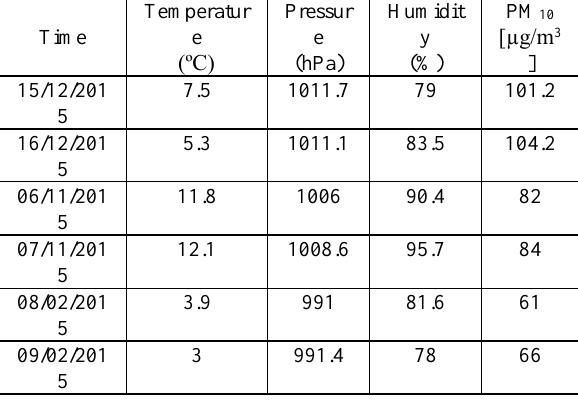
Table 3. Meteorological parameters of given days for PM10 comparison.